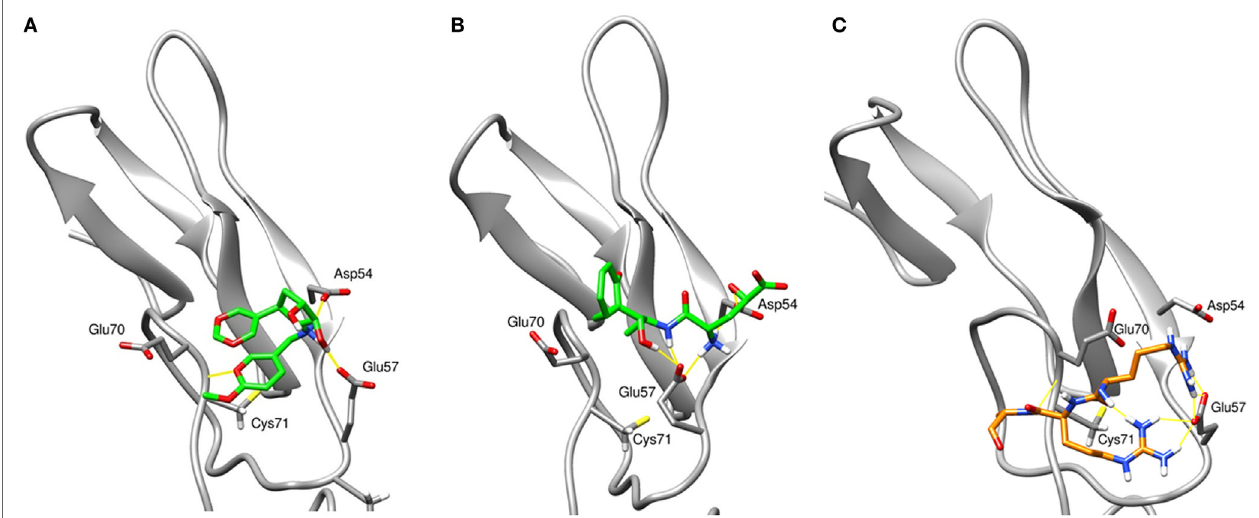
FiGUre 1 | The final snapshots of 15-ns molecular dynamics (MD) simulations of the TNF receptor type II (TNFR2)–ligand complexes: (A) compound ZiNc72321887 and (B) compound ZiNc67911837 at region 3 of TNFR2. (c) The binding pattern of TNF–TNFR2 at the 20-ns MD snapshot. Only contacting residues, such as Arg31, Arg32, and Ala33, of TNF are displayed. The TNFR2 protein is drawn with cartoon style in gray and the ligand or TNF with sticks in green or orange. Hydrogen bonds are indicated with yellow lines.